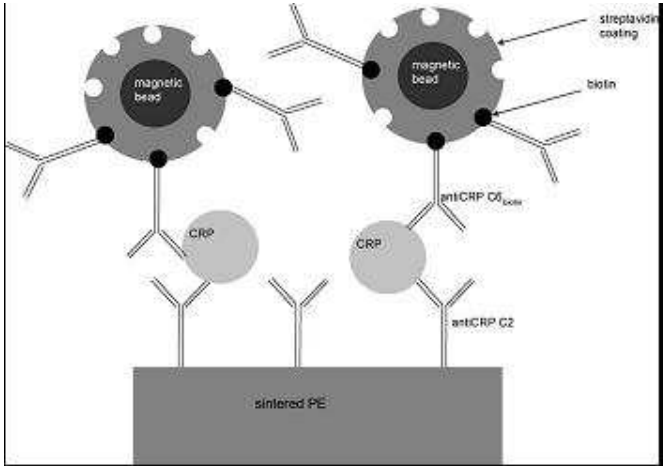
Figure 8. Magnetic sandwich bioassay for the detection of c-reactive protein (CRP) ( Reprinted from [24] with permission from Elsevier